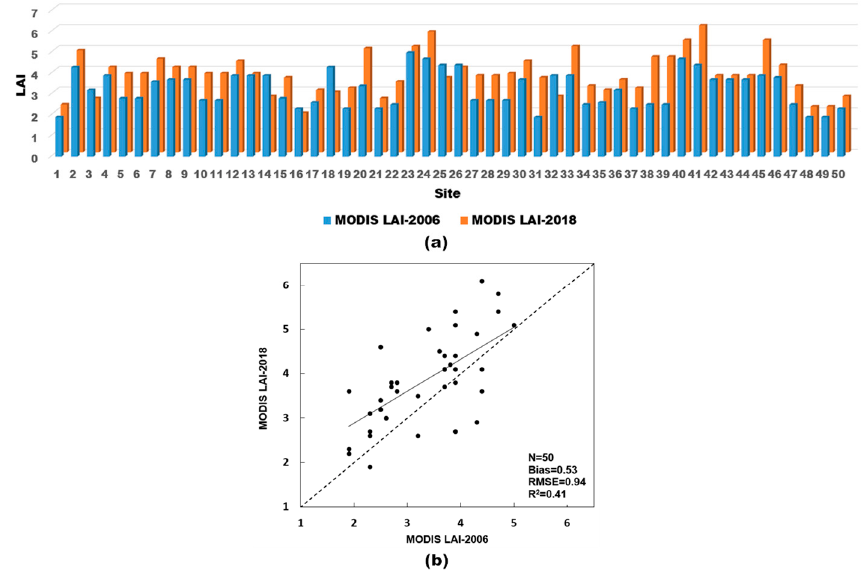
Figure 11. Evaluation of LAI variation in 10 years using Moderate Resolution Imaging Spectroradiometer (MODIS) LAI product. ( a ) is the column plot displaying the variation between MODIS LAI of 2018 and 2006. ( b ) is the scatter plot displaying the correlation between MODIS LAI of 2018 and 2006.